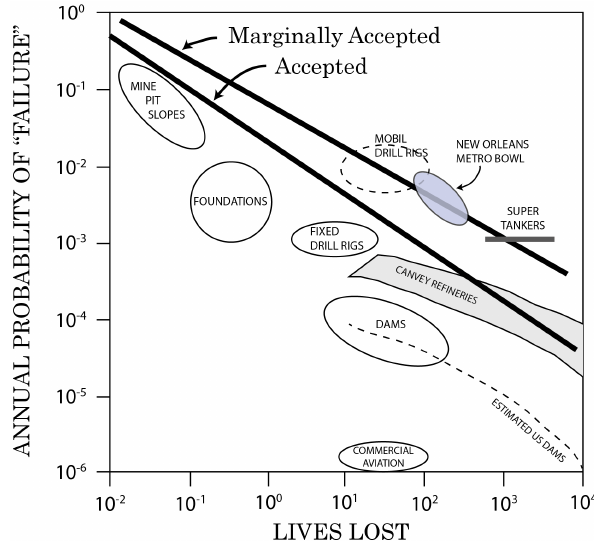
Figure 10. FN chart of common civil infrastructure risks (Lambe et al.,